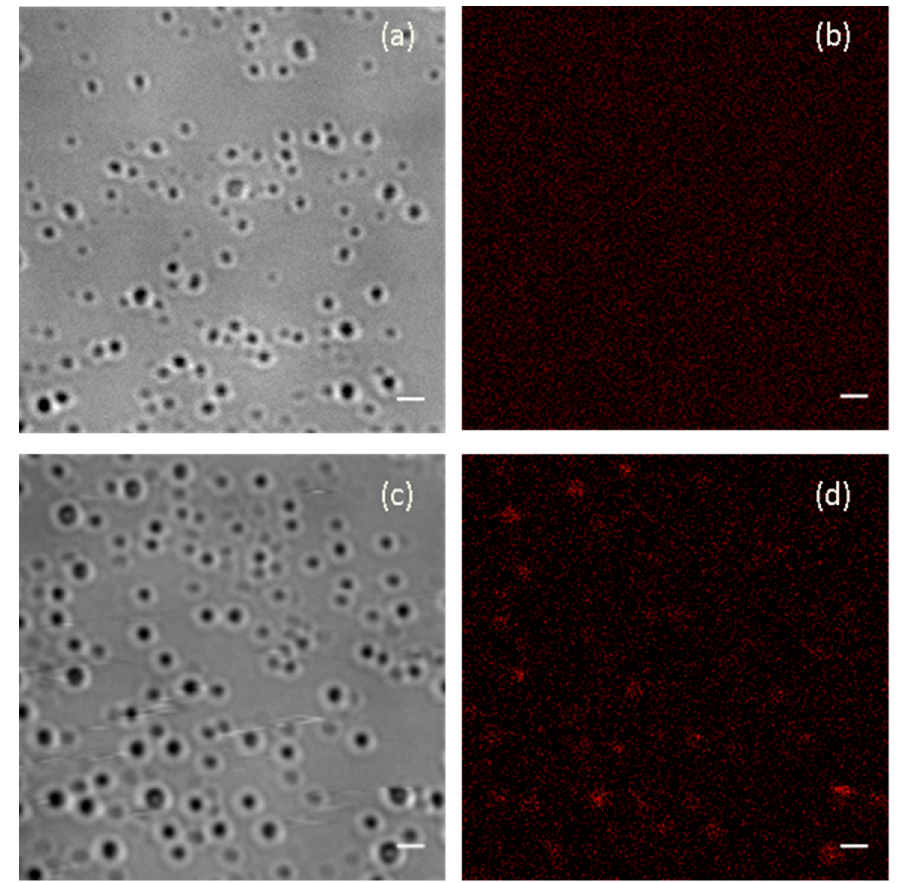
Figure 1. Transmission andfluorescence microscopy images of ( a , b ) polylactic acid nanoparticles (PLA NPs) and ( c , d ) polylactic acid/5-lemongrass oil nanocapsules (PLA/5-LG NCs) repsectively (scale bars, 1 μ m).